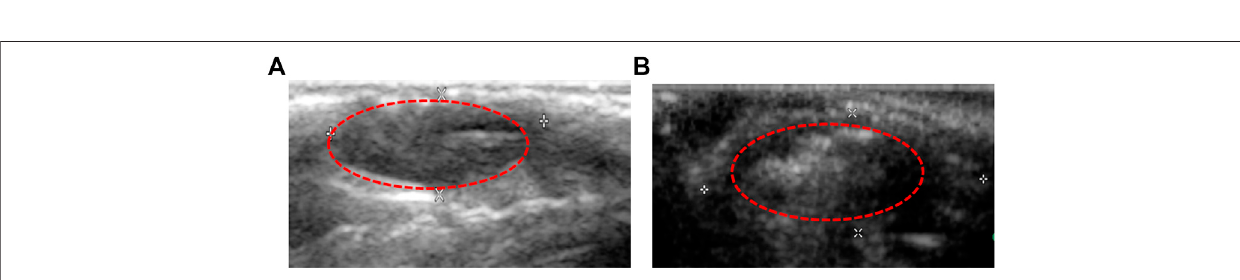
Figure 9 | Ultrasound images of the subcutaneous tumor in BALB/c nude mice. (A) and (B) are before and after injection of Lf – PLLA